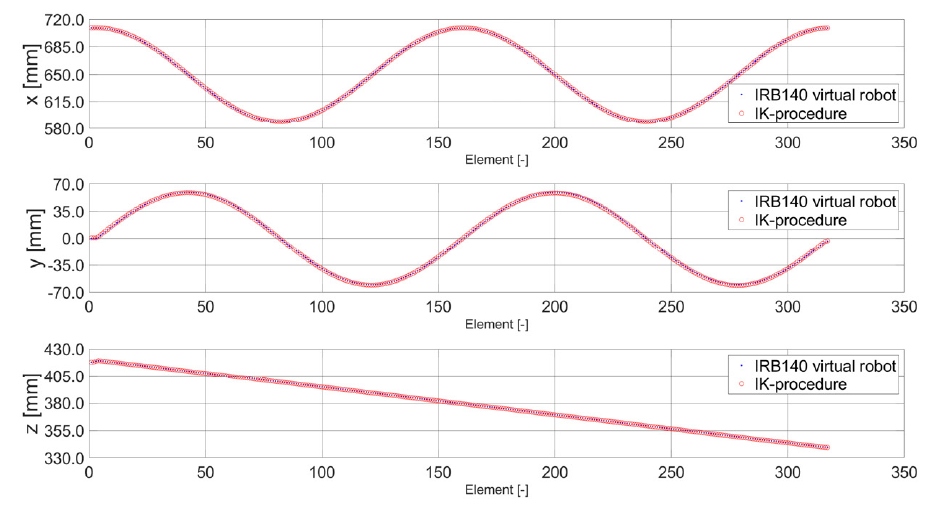
Figure 8. Spiral X-Y along Z-direction: X-, Y-, Z- axes Virtual IRB140 vs. IK procedure.